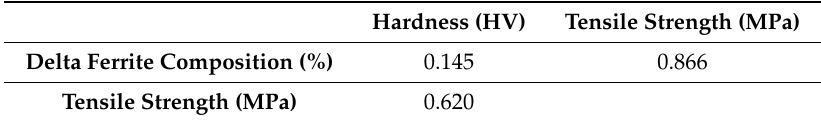
Table 7. Pearson correlation coe ffi cient between delta ferrite composition and mechanical properties of austenitic stainless steel at high annealing temperatures (650–1050 ◦ C).